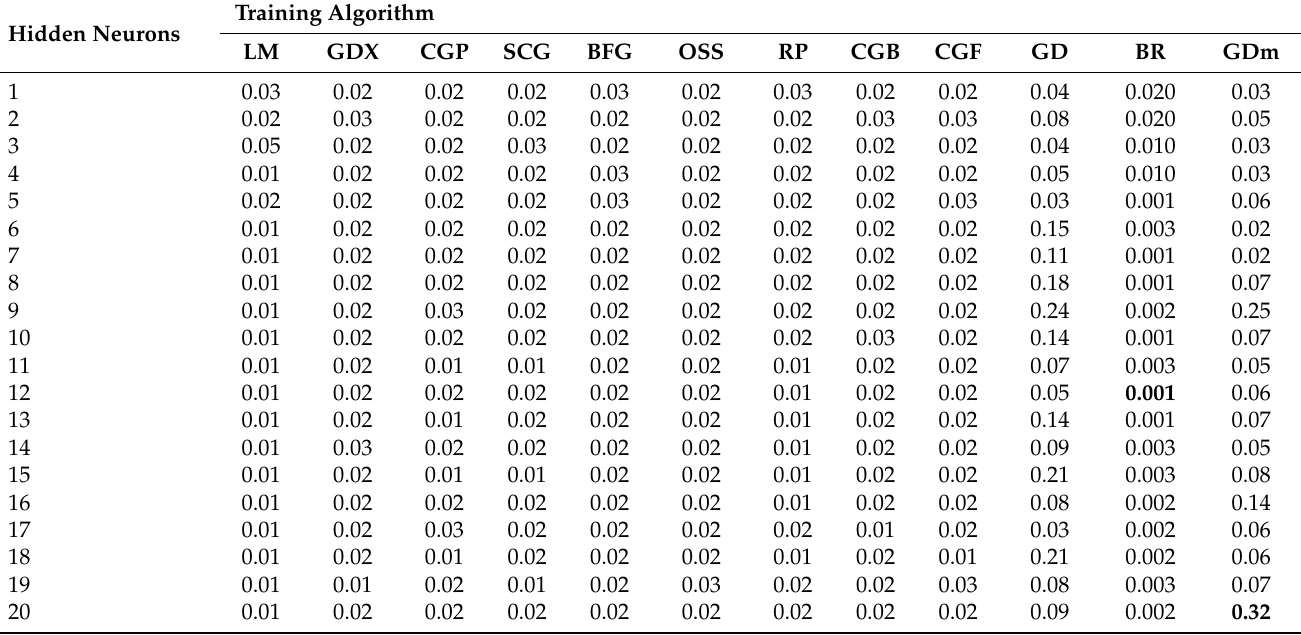
Table A13. MAPE for percentage of CH4 in biogas for different training algorithms at different number of hidden neurons.